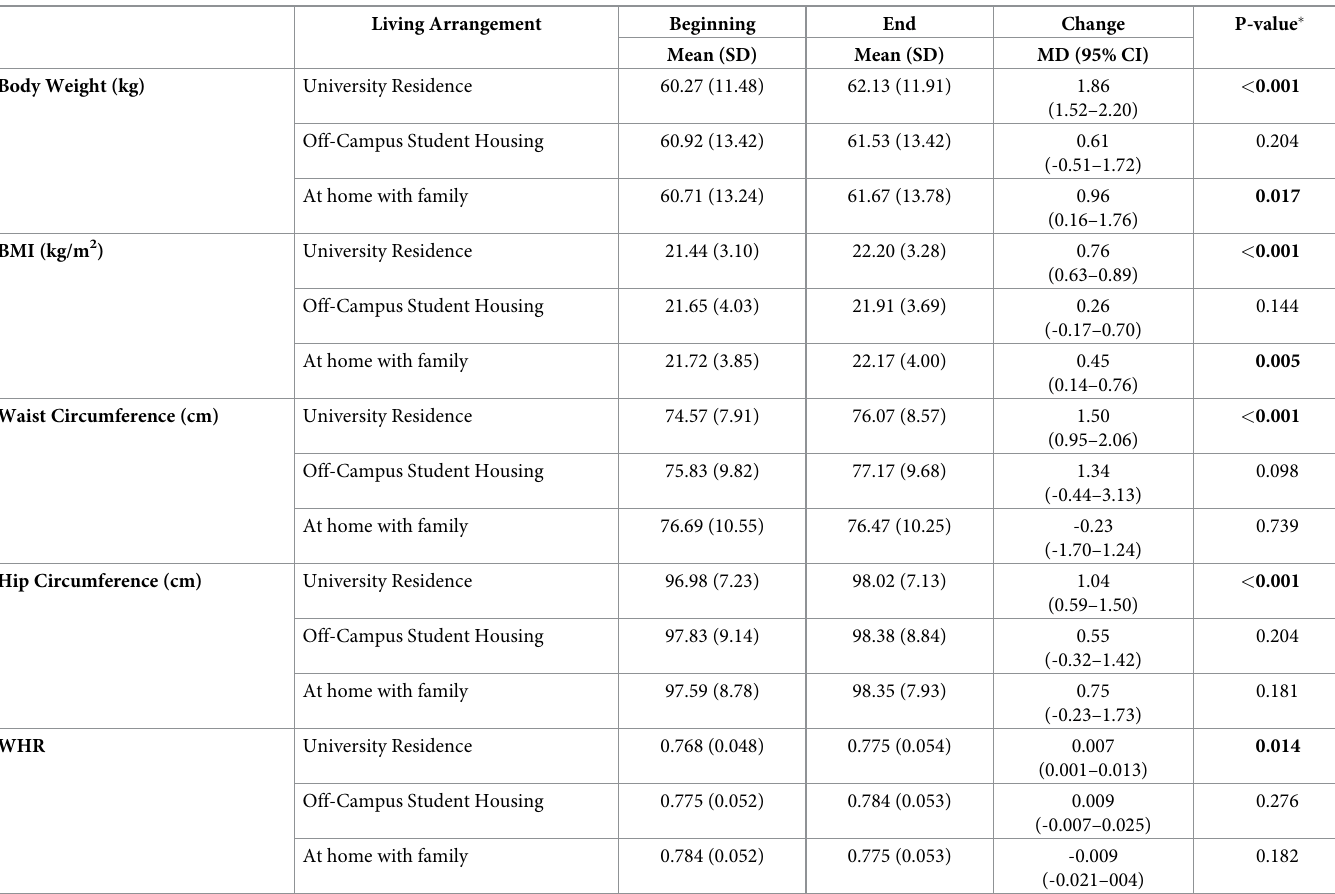
Table 2. Trends from beginning to the end of first year in students living on campus residence (n = 170), in off-campus housing (n = 26), and at home with family (n = 48). Living Arrangement Beginning End Change P-value